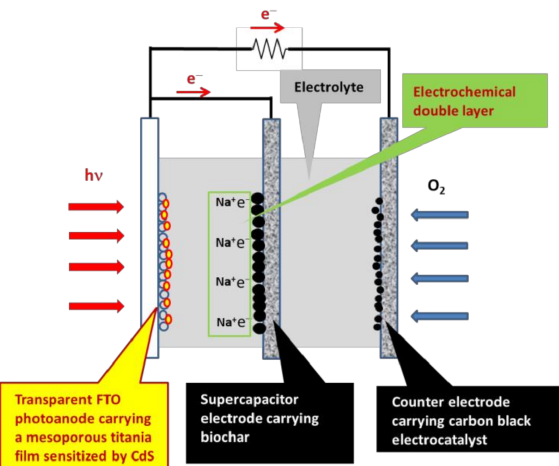
Figure 1. Schematic illustration of the photocatalytic fuel cell carrying a third (supercapacitor) elec- trode. The photoanode was made by depositing a mesoporous CdS/TiO 2 film on a transparent fluorine doped tin oxide (FTO) electrode. The cathode electrode was a carbon cloth carrying a hy- drophobic gas diffusion layer made of carbon black. The supercapacitor electrode was a carbon cloth carrying a film made of biochar particles and a small percentage of carbon black. Photogenerated holes are consumed mainly by oxidation of an added organic fuel and secondarily water. Photogen- erated electrons produce an electric current and are partly consumed to charge the supercapacitor. The rest are consumed by reducing atmospheric